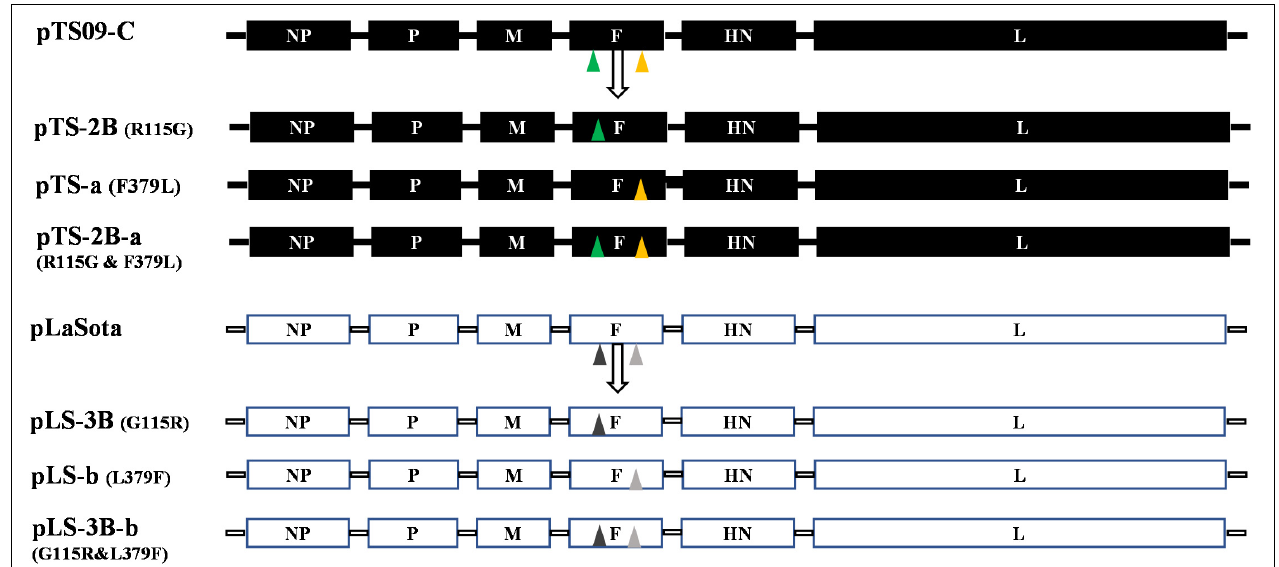
FIGURE 2 | Schematic representation showing the construction of mutant NDVs. The mutated ICs containing the R115G and/or F379L substitution(s) were designated as pTS-2B, pTS-a, and pTS-2B-a, respectively, according to the mutation sites. The mutated ICs containing the G115R and/or L379F substitution(s) were designated as pLS-3B, pLS-b, and pLS-3B-b, respectively. The triangles with different colors indicate the different